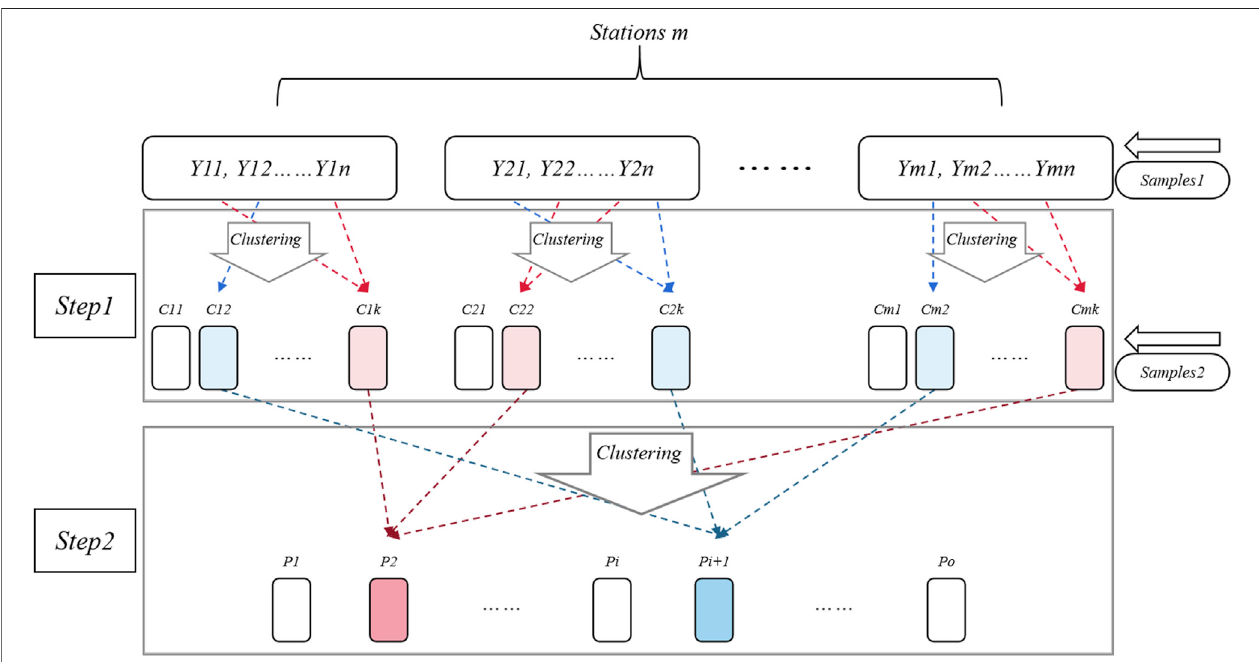
FIGURE 2 | The schematic diagram of the two-step clustering